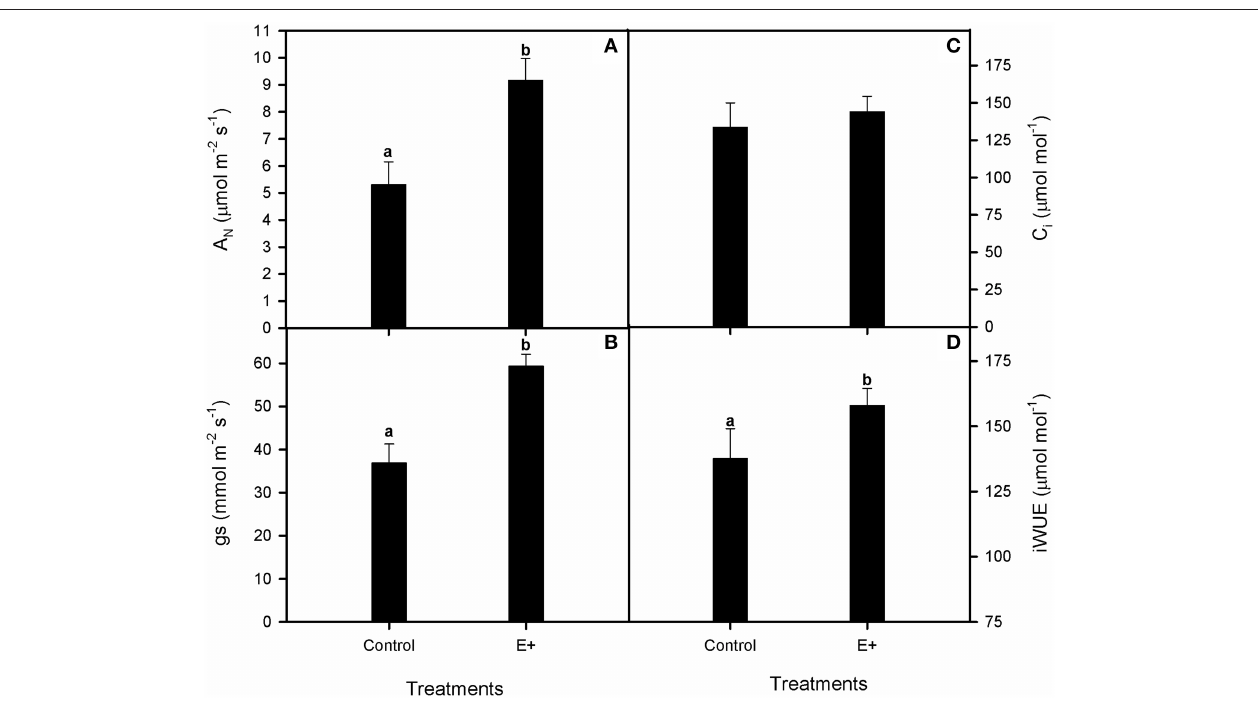
FIGURE 5 | Effect of inoculation with the endophytic bacterial consortium on net photosynthetic rate, A N (A), stomatal conductance, gs (B), intercellular CO 2 concentration, C i (C) and intrinsic water-use efficiency, iWUE (D) in leaves of Spartina maritima plants grown in natural soil from Tinto marsh for 30 days. Values are means ± s.e. ( n = 10 ). Statistical differences between means are indicated by different letters ( P < 0.05